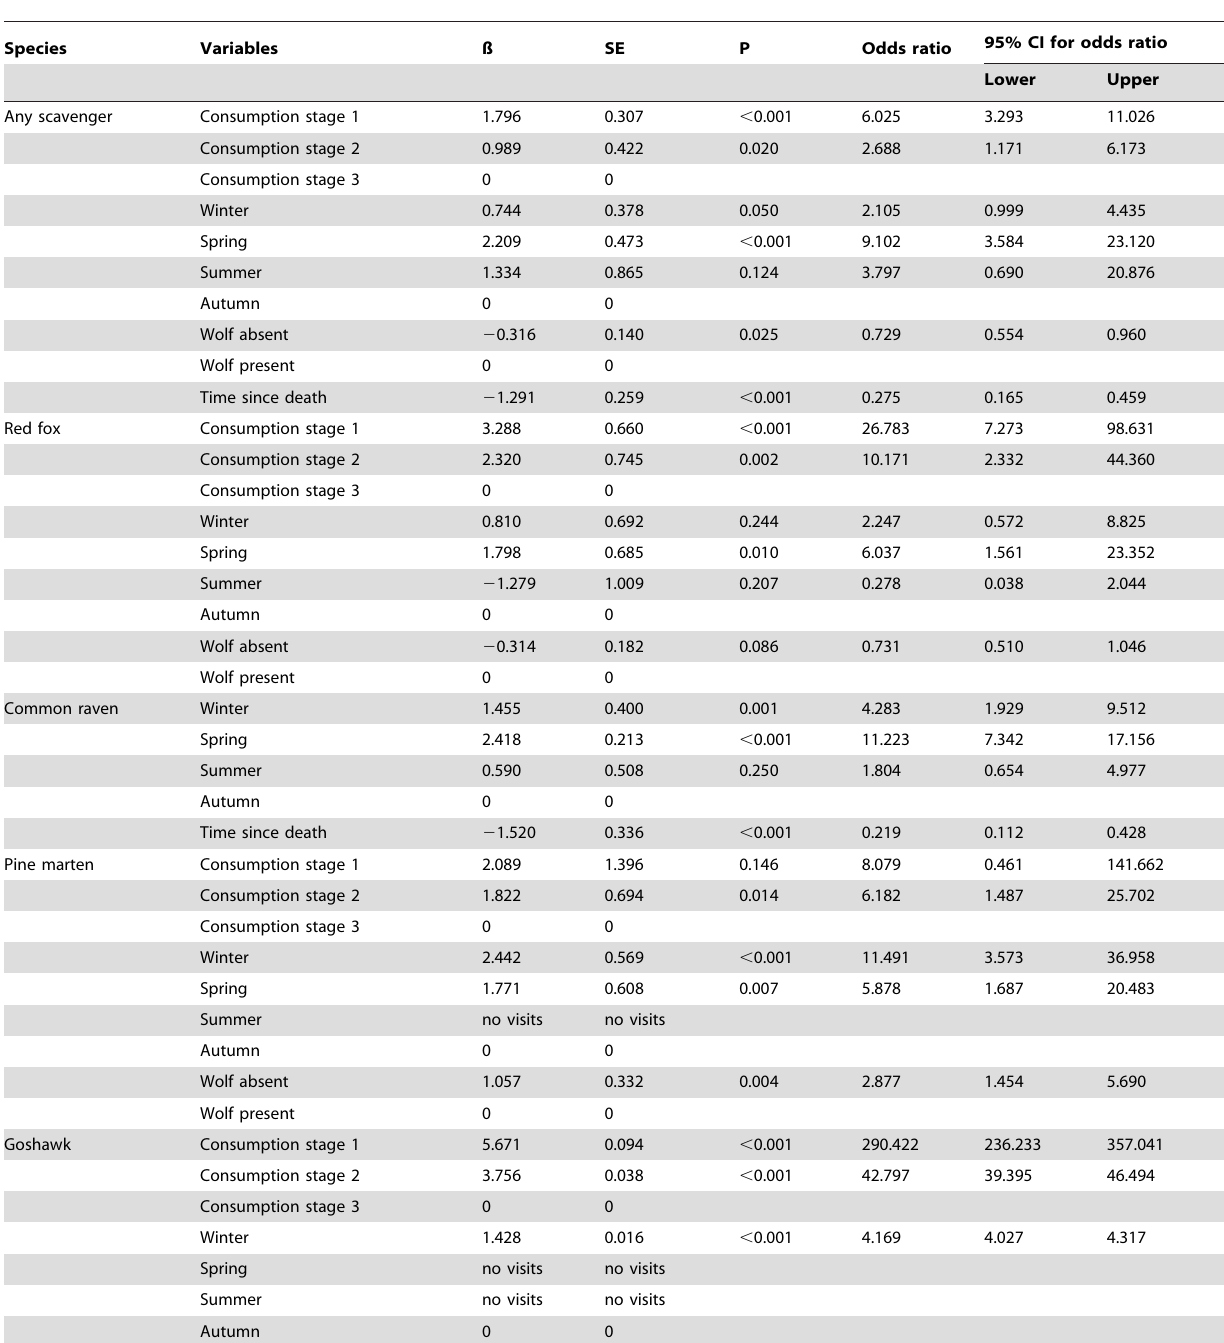
Table 4. Parameter estimates (ß) of consumption stage, season of the year, presence of wolves, and time since death of moose on number of visits by scavenging species to wolf-killed moose (n =49), during ten-day periods (n=223).